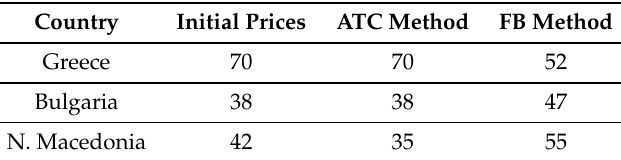
Table 3. Market prices for the 3 countries.